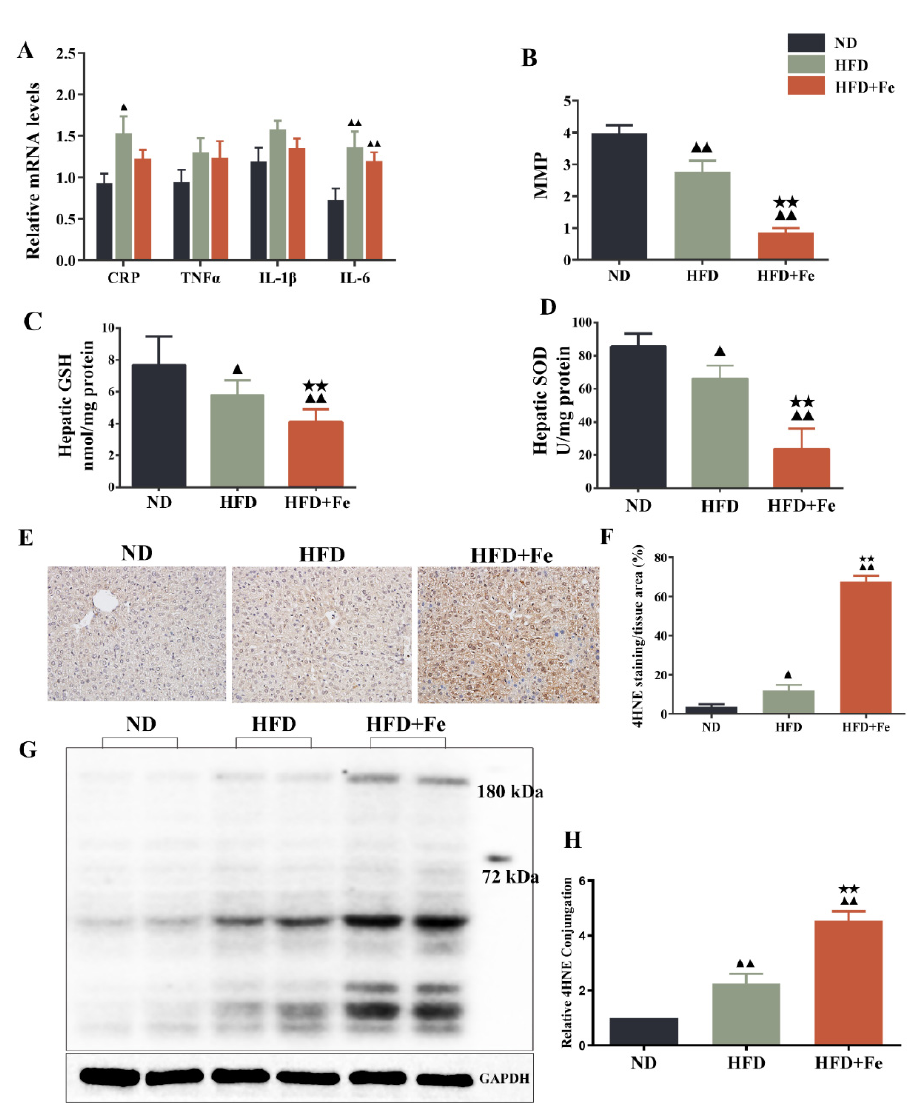
Figure 4. Dietary iron overload-induced hepatic oxidative damage in ApoE KO mice. ( A ) Inflammatory markers. ( B ) Hepatic levels of matrix metalloproteinase (MMP). ( C , D ) Hepatic levels of glu- tathione (GSH) and superoxide dismutase (SOD). ( E ) Immunohistochemical staining of 4 ‐ hydroxy ‐